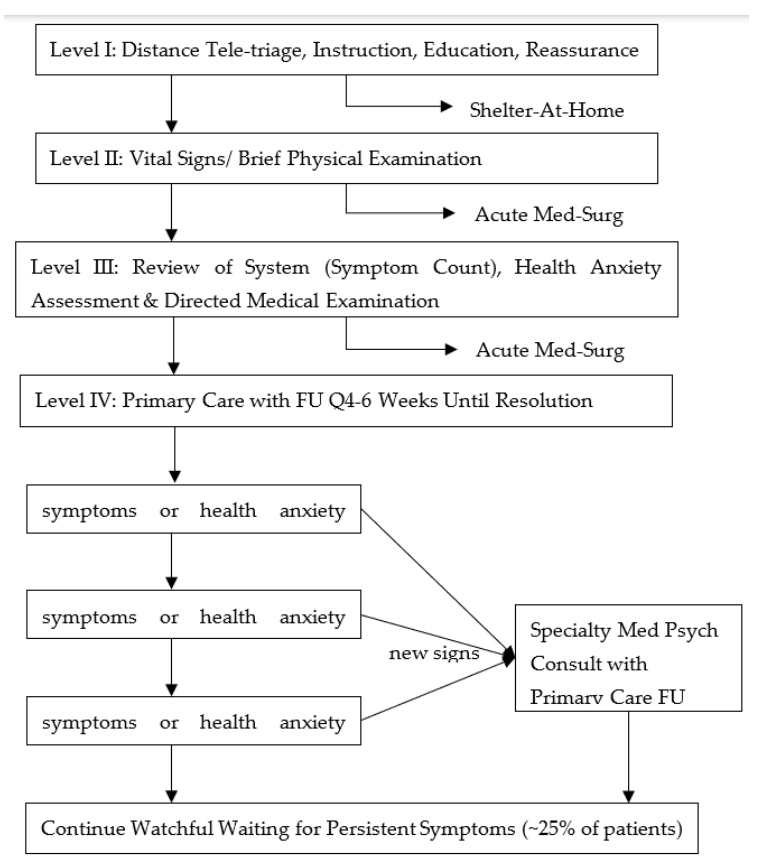
Figure 12. Triage algorithm for patients with possible idiopathic physical symptoms and acute health anxiety after a terrorist attack.